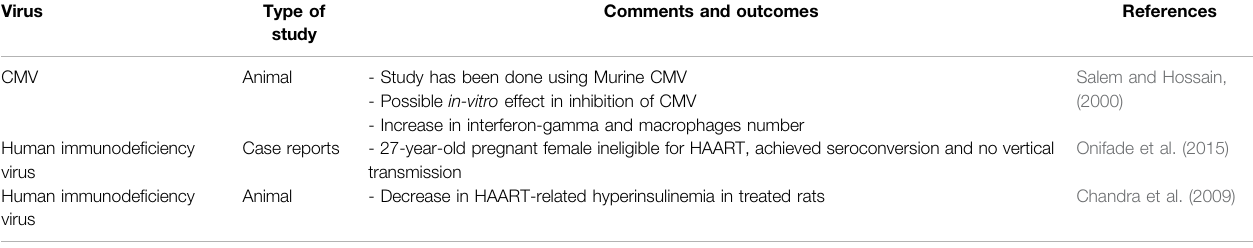
TABLE 2 | Selected examples of the anti-viral effects of Thymoquinone (TQ) and Nigella sativa extracts. Virus